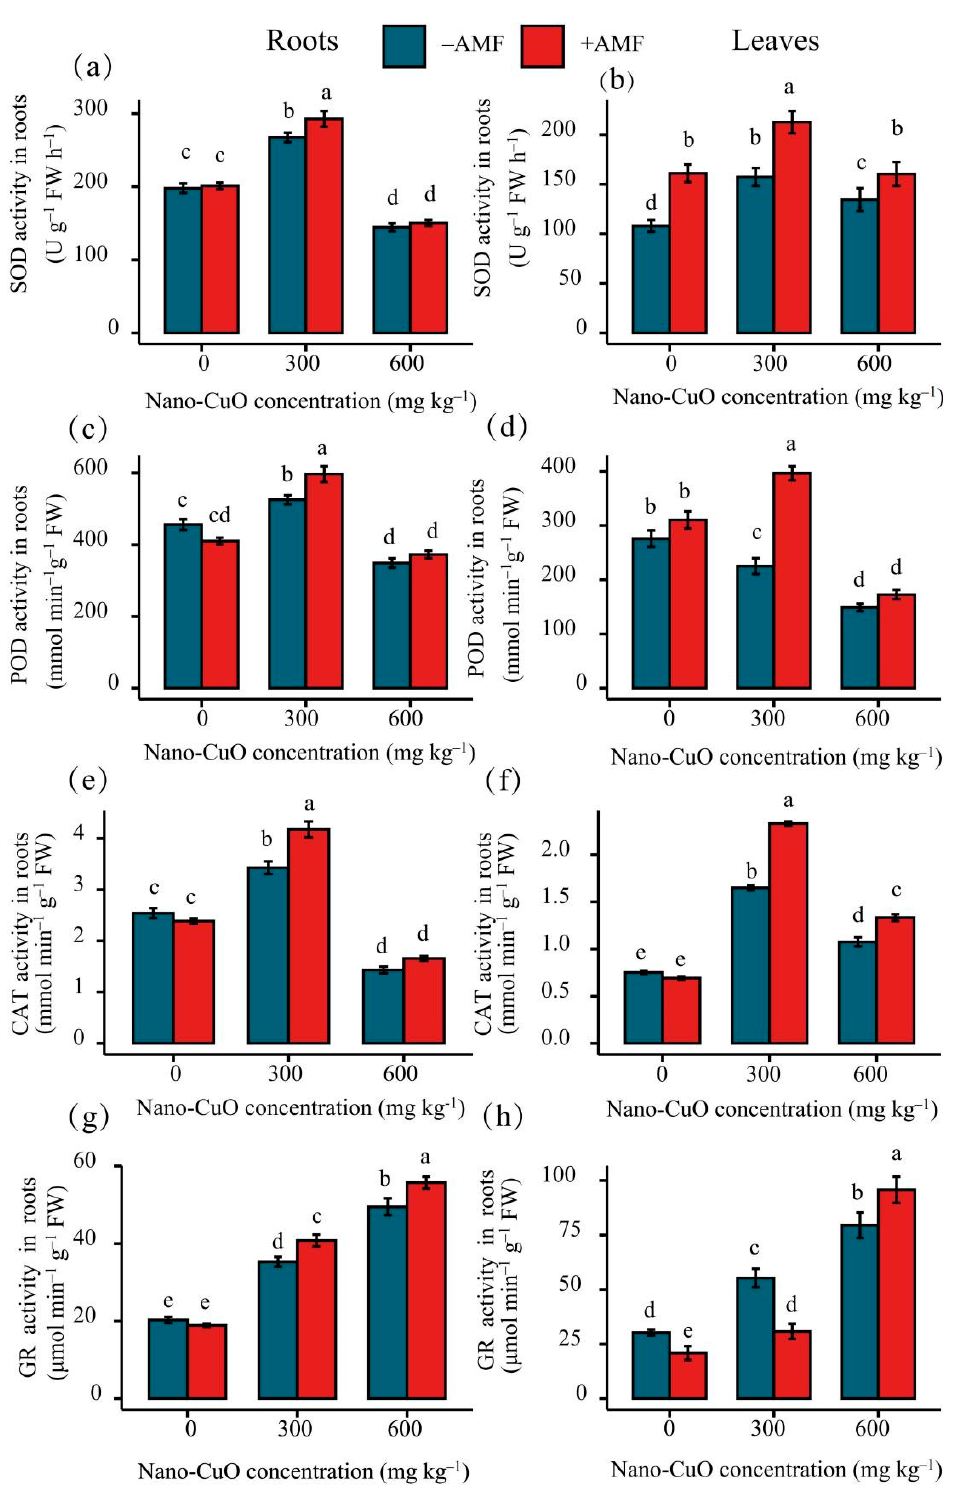
Figure 4. Effects of AMF on the antioxidant enzymes of C. indica seedlings under nano-CuO stress. Total superoxide dismutase (SOD) activity in C. indica roots ( a ) and leaves ( b ); peroxidase (POD) activity in C. indica roots ( c ) and leaves ( d ); catalase (CAT) activity in C. indica roots ( e ) and leaves ( f ); glutathione reductase (GR) activity in C. indica roots ( g ) and leaves ( h ). Different lowercase letters show significant differences between treatments ( p < 0.05). The plants exposed to nano-CuO had significantly elevated levels of ROS (H 2 O 2 and O 2 − ) in the root and leaf tissues compared to the control plants (Figure 5). When the AMF